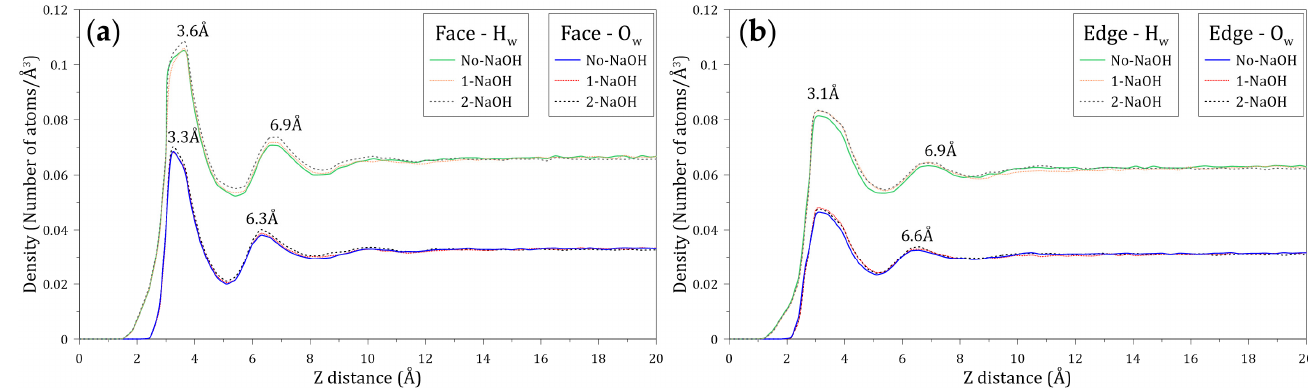
Figure 7. Density profiles of the oxygen (O w ) and hydrogen (H w ) atoms of the water molecules located along the Z axis normal to the ( a ) molybdenite face and ( b ) edge surfaces. These calculations were conducted at different concentrations of NaOH.